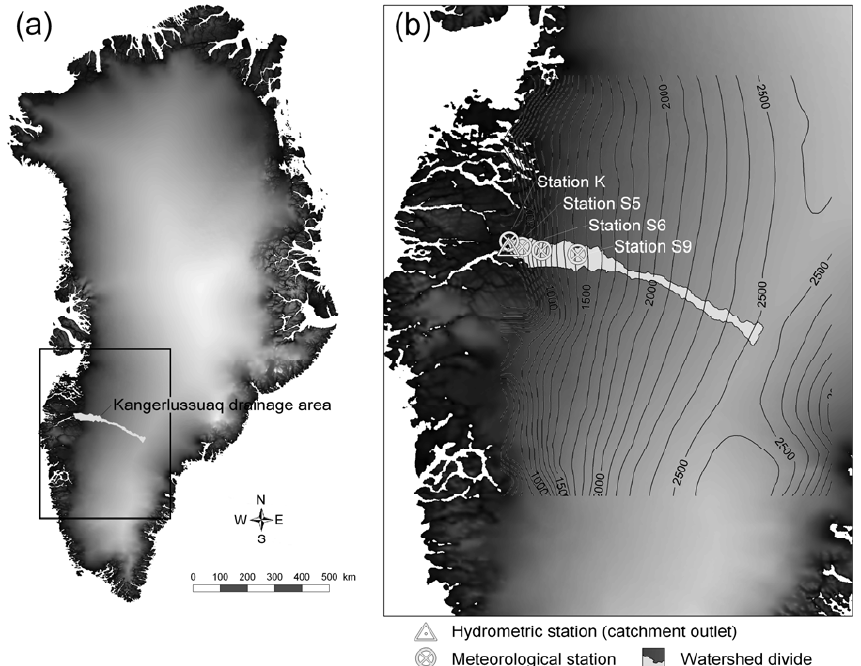
Fig. 1. (a) Greenland including the Kangerlussuaq drainage area (6130 km 2 ) in West Greenland; (b) simulation area with topography (gray shades, and 100-m contour interval), the four meteorological stations: Station K (50 m a.s.l.), S5 (490 m a.s.l.), S6 (1020 m a.s.l.), and S9 (1520 m a.s.l.), the hydrometric station at the catchment outlet, and the catchment watershed divide. The catchment watershed divide was established in River Tools based on the surface DEM by Bamber et al. (2001).